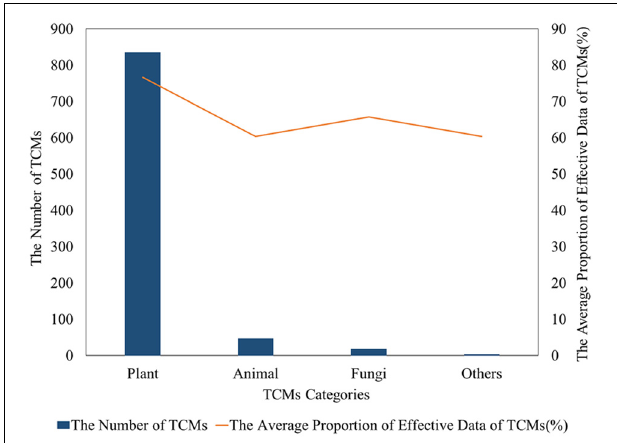
FIGURE 2 | Distribution of antibacterial TCMs from different sources.